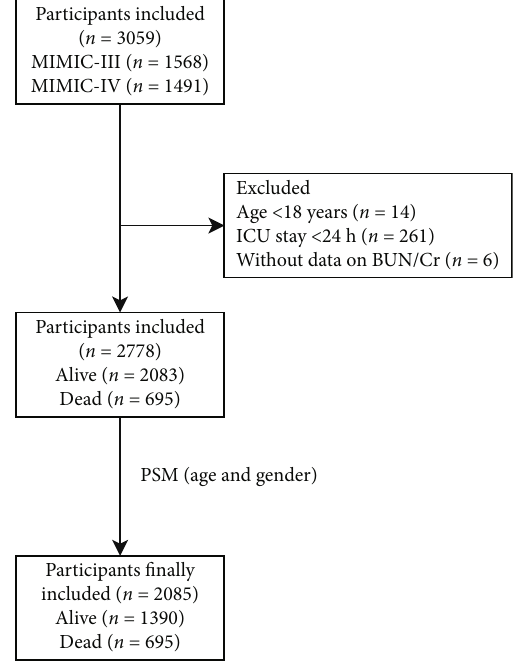
Figure 1: The screen process of participants in this